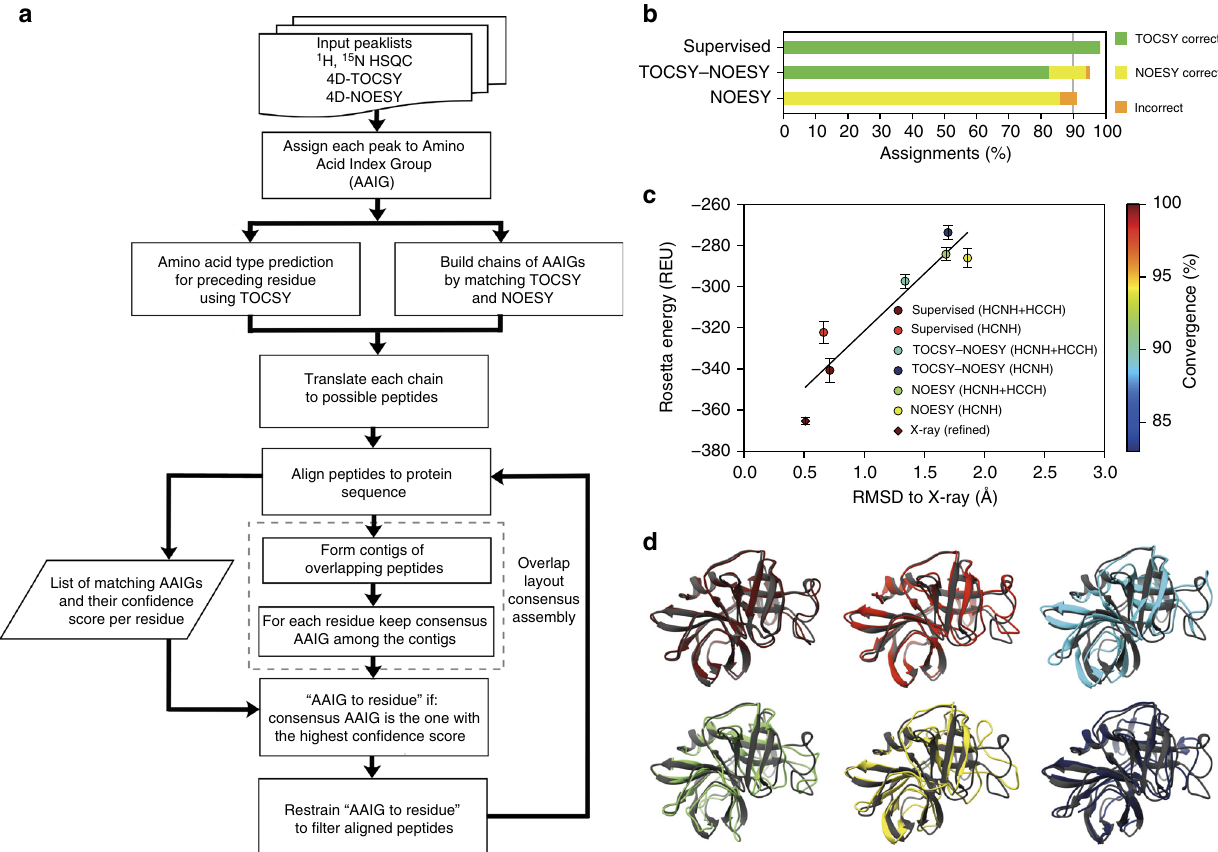
Fig. 3 Automated structure determination using 4D-CHAINS/autoNOE-Rosetta. a Flowchart of the 4D-CHAINS algorithm for automated NMR resonance assignment from two 4D spectra (TOCSY and NOESY). b Quality of 4D-CHAINS assignments for supervised, TOCSY – NOESY, and NOESY settings, expressed as the average for the four different protein targets. c , d Performance of different 4D-CHAINS assignment scenarios for a 198 aa protein, α -lytic protease, calculated using autoNOE-Rosetta. c Goodness of structural ensembles is measured using the Rosetta all-atom energy function, backbone heavy atom RMSD to X-ray structure (PDB ID 1P01) and degree of structural convergence. Average energy values (in Rosetta Energy Units (REU)) for ensembles calculated using indicated data/assignment scenarios, with errors bars shown at 1 standard deviation. Also shown is the average energy of 10 locally re fi ned X-ray structures (diamond) — re fi nement adapts the X-ray structure to the local optimum of the Rosetta energy, with a minimum change in RMSD (0.5 Å). The color of points represents the average % of converged residues in each ensemble, according to the color scale on the right. d Lowest-energy structures in each ensemble (shown in the same color as the points in c ) superimposed on the X-ray reference structure (gray). Images of structures were produced using Chimera